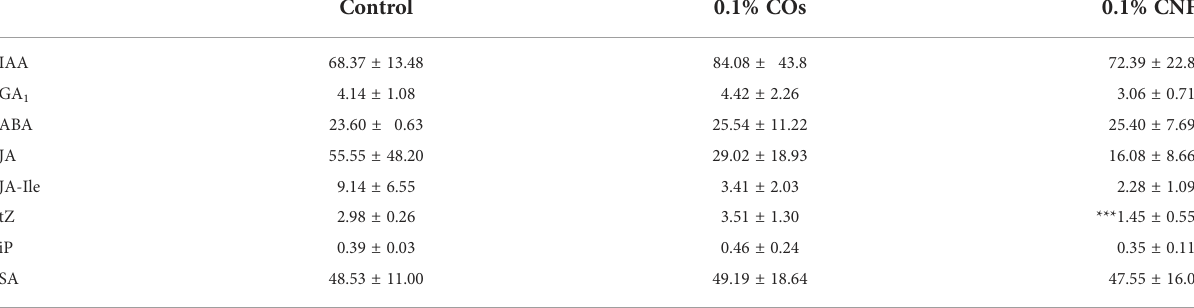
TABLE 2 Levels of endogenous phytohormones upon induction by